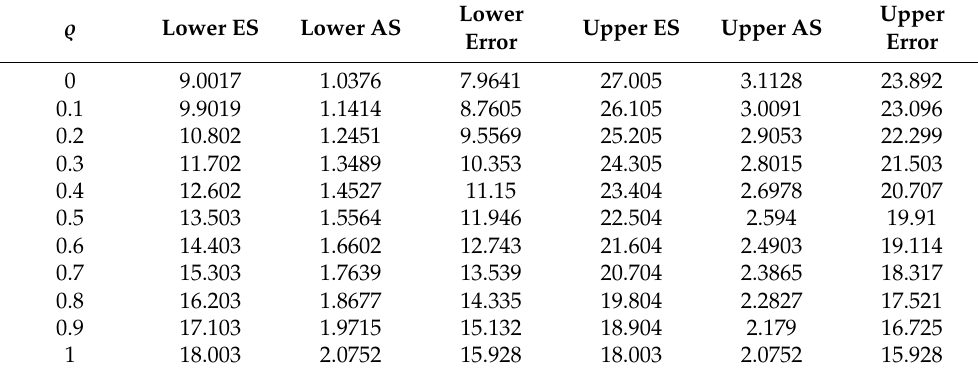
Table 1. Table for the error term between exact solutions (ES) and approximate solutions (AS).